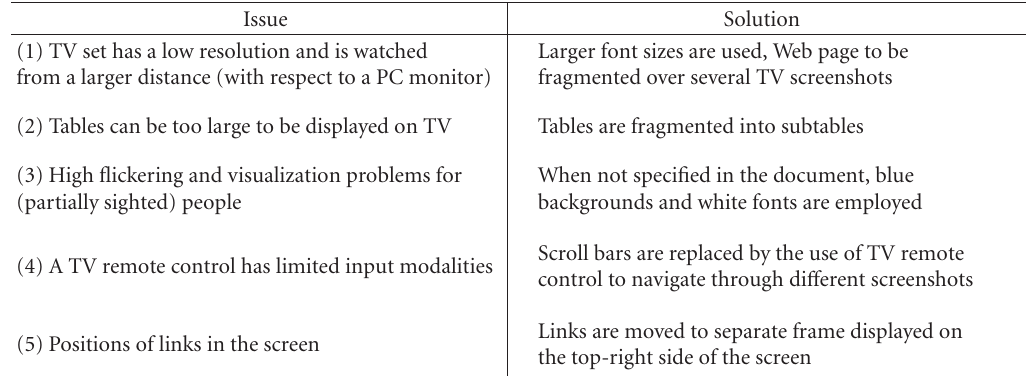
Table 2: TV visualization: issues and